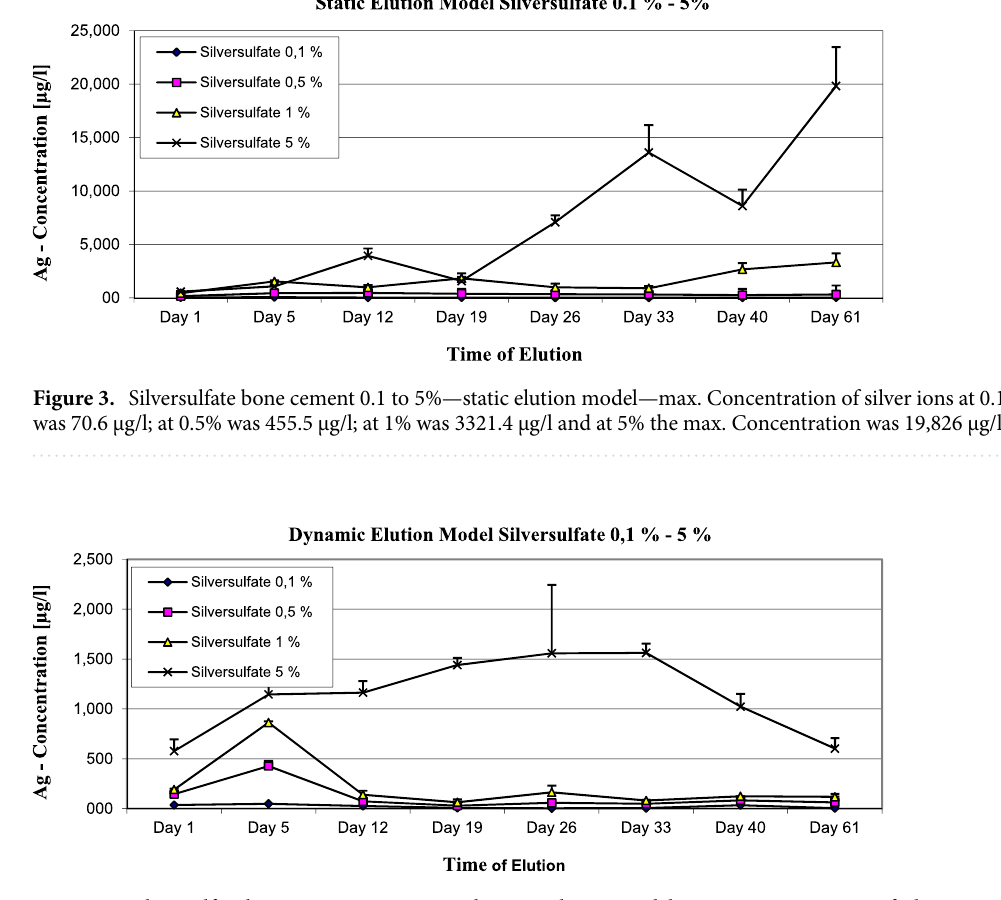
Figure 4. Silver sulfate bone cement 0.1 to 5%—dynamic elution model—max. Concentration of silver ions at 0.1% was 48.57 µg/l; at 0.5% was 427 µg/l; at 1% 863 µg/l and at 5% the max. Concentration was 1561.75